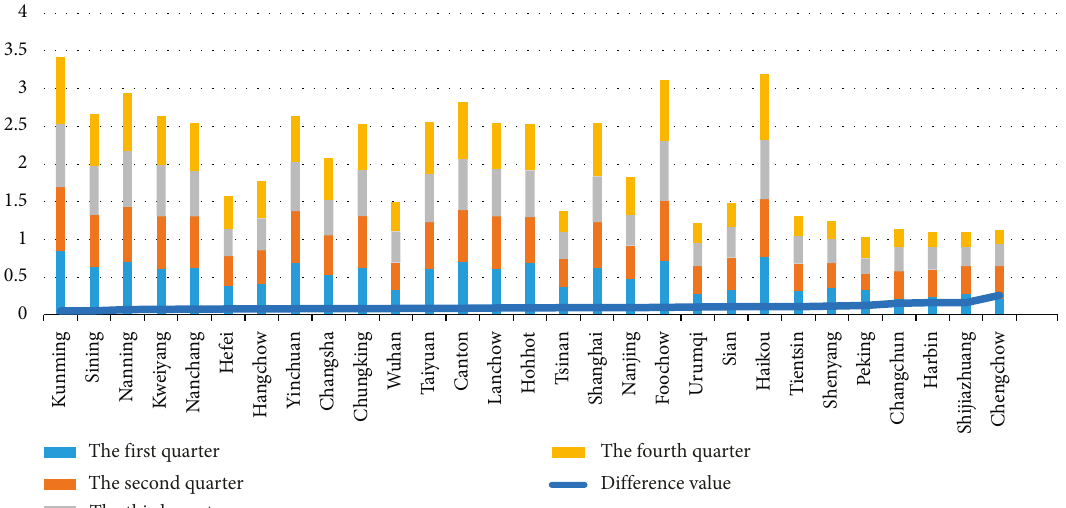
Figure 2: Quarterly change of the urban human settlements quality index.